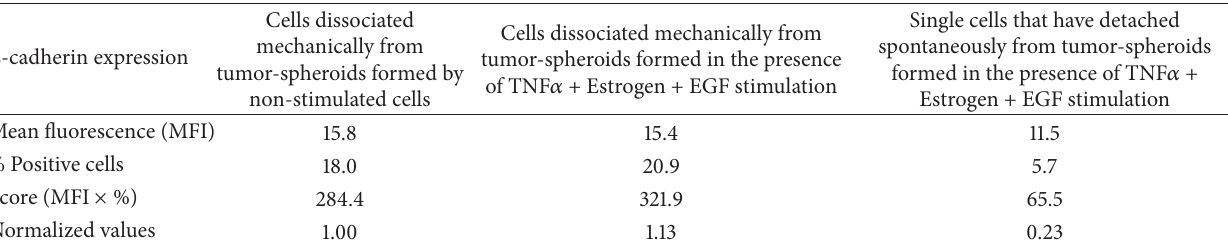
Table 1: Breast tumor cells that migrated out of tumor-spheroids following TNF 𝛼 + Estrogen + EGF stimulation express reduced levels of